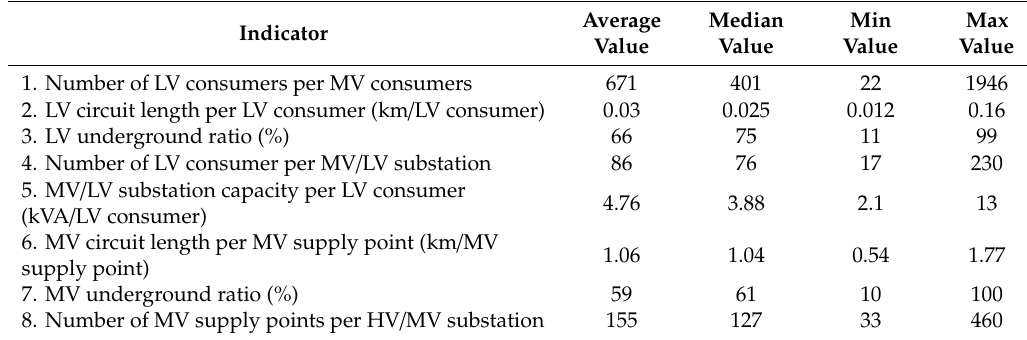
Table 1. Distribution system operators’ (DSOs) indicators.